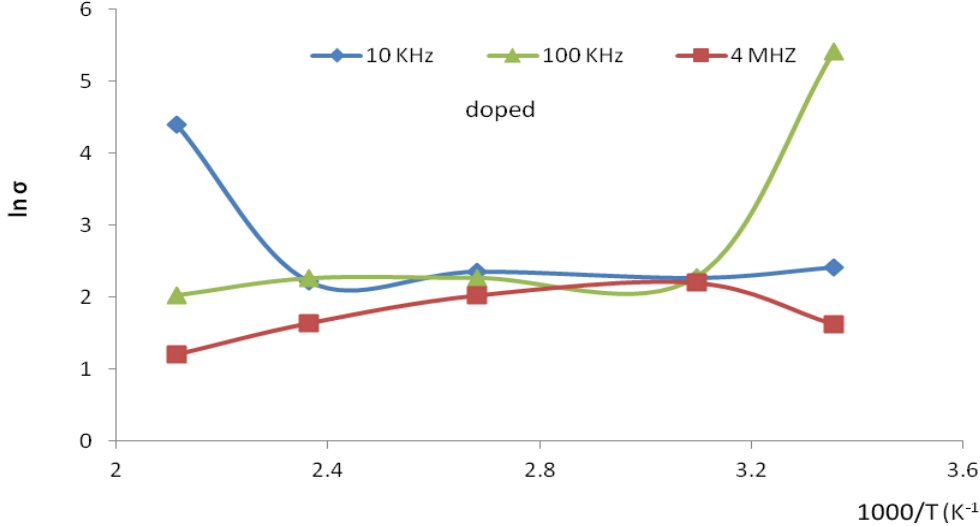
Fig. 9: The variation of ln σ with 1000/T for doped ZnS films. Table 3: Values of activation energy E